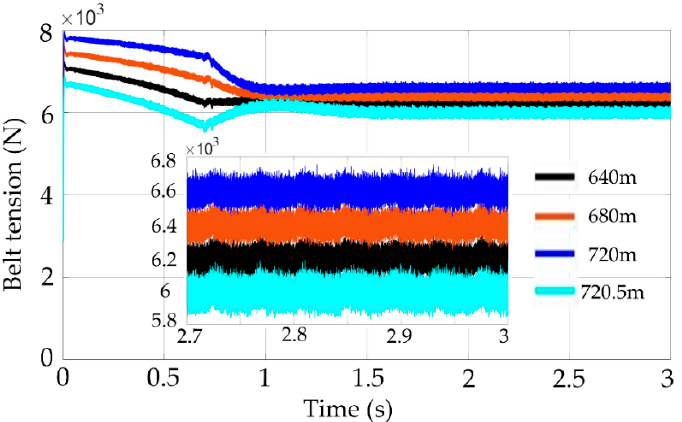
Figure 13. Conveyor belt tension waveform diagram on the 6 group of driving mechanism under light load operating conditions.